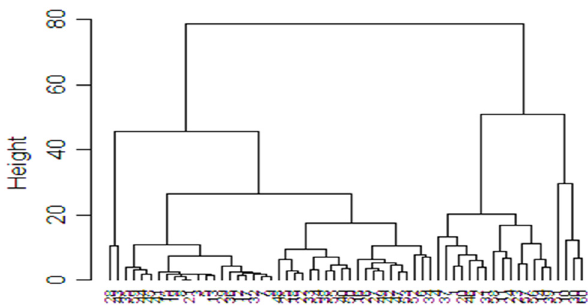
Figure 10: Clustering patterns of the 60 - cowpea accessions con - structed based on the neighbour - joining algorithm using the unweighted pair group method ( UPGMA ) according to drought tolerance and yield - related